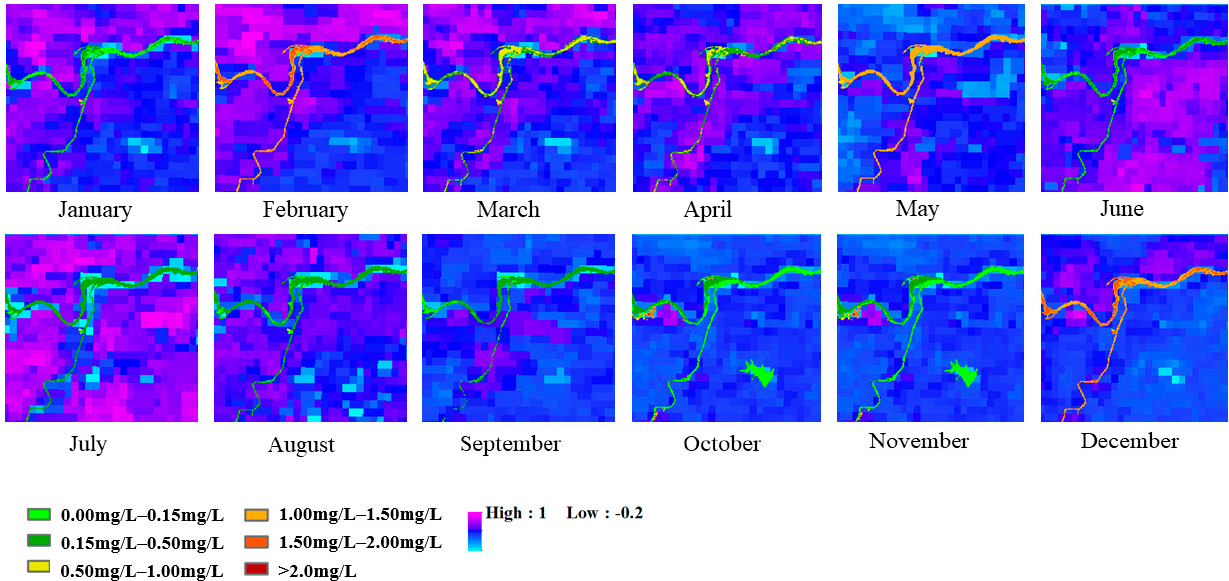
Figure 13. Region (c) monthly NH 3 -N concentration and NDVI changes.